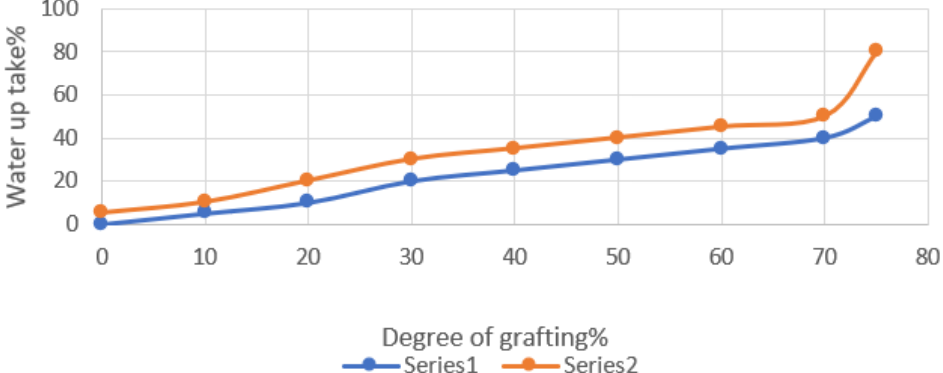
Figure 5. Effect of the degree of grafting on the swelling behavior of PP-g-An-AAc before and after NH 2 OH treatment. (Series1) grafted, (Series2) treated.